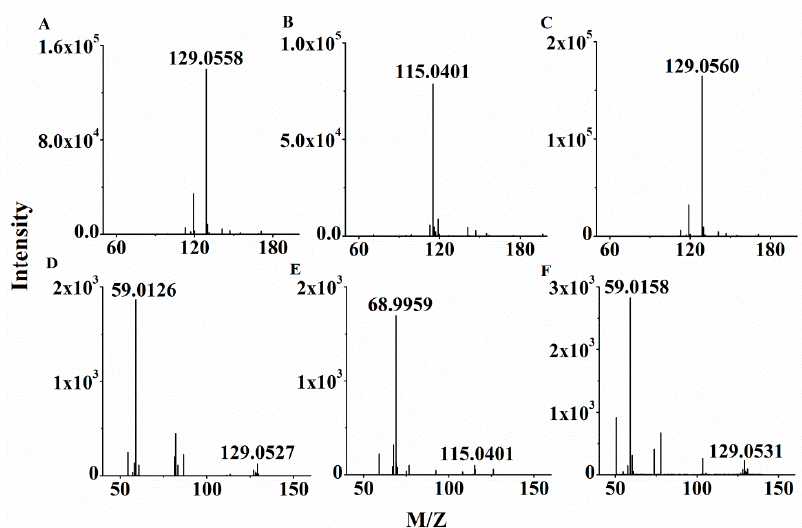
Figure 3. The mass spectra of the branched-chain keto acids standards using HPLC-Q-TOF/MS. ( A ) Full scan mass spectra of α -keto- β -methylvalerate (KMV); ( B ) Full scan mass spectrum of α - ketoisovalerate (KIV); ( C ) Full scan mass spectrum of α -ketoisovalerate (KIC); ( D ) MS/MS spectrum of KMV; ( E ) MS/MS spectrum of KIV; ( F ) MS/MS spectrum of KIC.